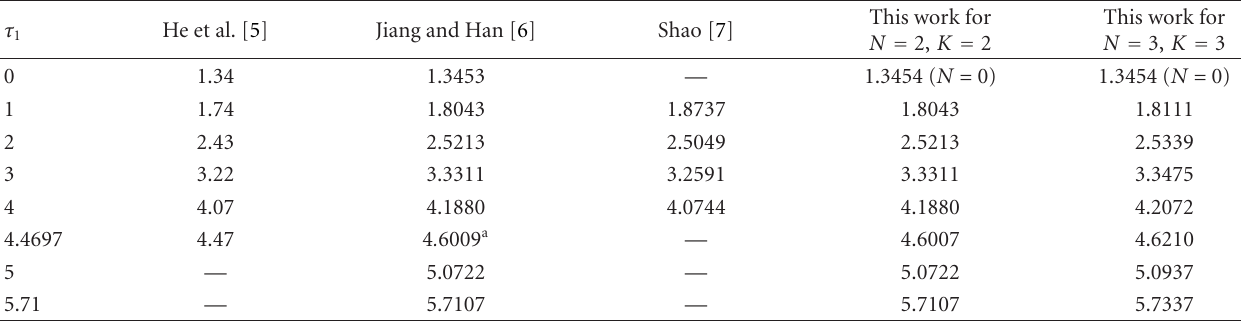
Table 1: MAUB of the time-varying delay for di ff erent μ